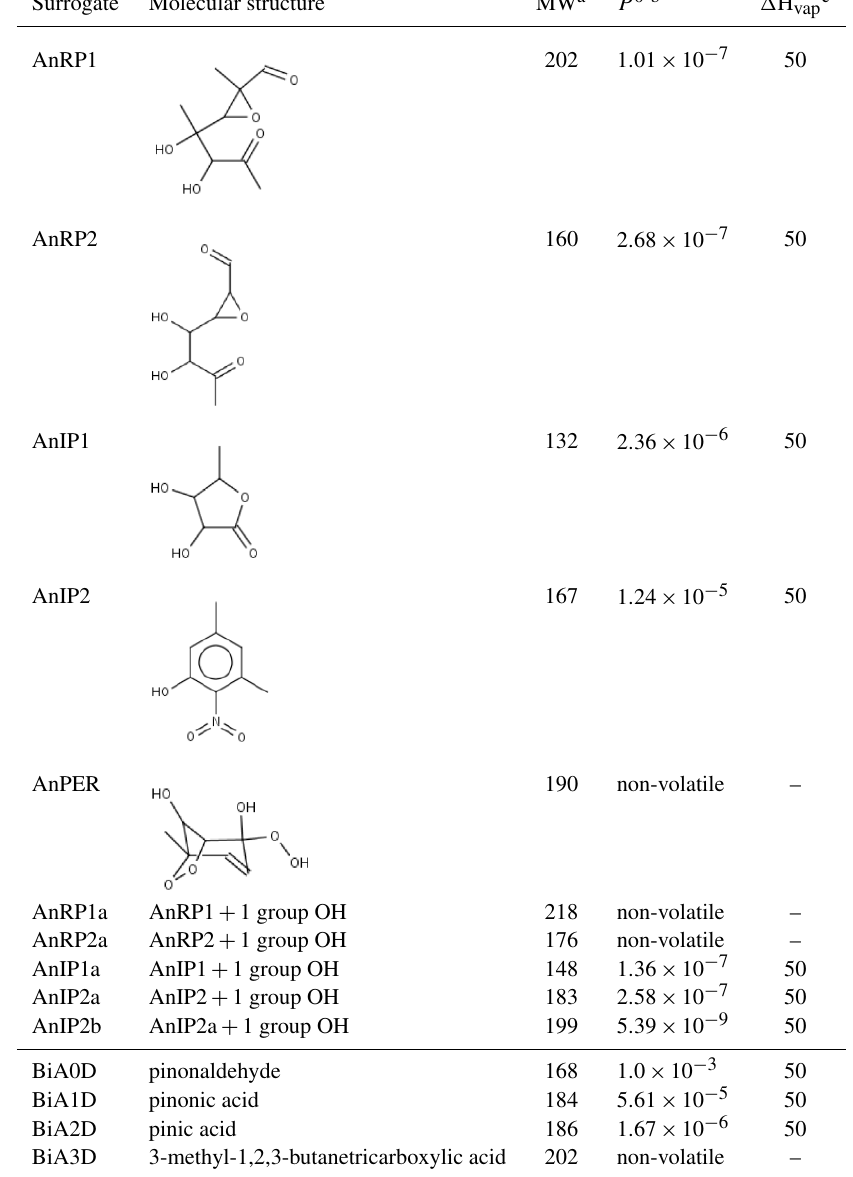
Table 3. Properties of the different surrogate SOA species.